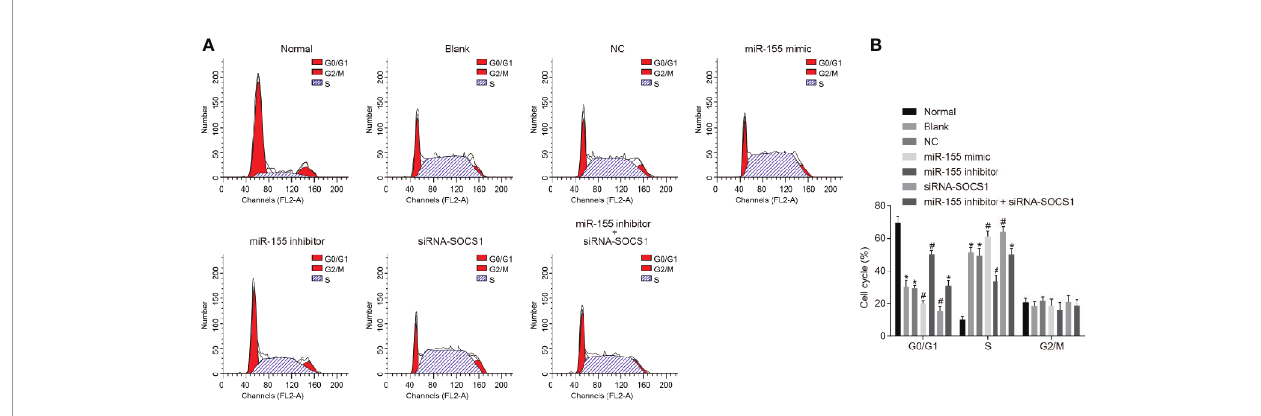
FIGURE 7 | miR-155 upregulation and SOCS1 silencing promote the cell cycle entry of hepatic stellate cells. (A) Cell cycle progression of differently transfected hepatic stellate cells. (B) Quantitative analysis of cell cycle rate in transfected cells. * p < 0.05 vs. normal hepatic stellate cells, # p < 0.05 vs . cells without any treatment and cells treated with miR-155 NC. The measurement data are expressed as mean ± standard deviation. Data comparisons between different groups were performed by using one-way ANOVA, with Tukey ’ s post-hoc test for backtesting. Cell experiments were repeated three times. ANOVA, analysis of variance.